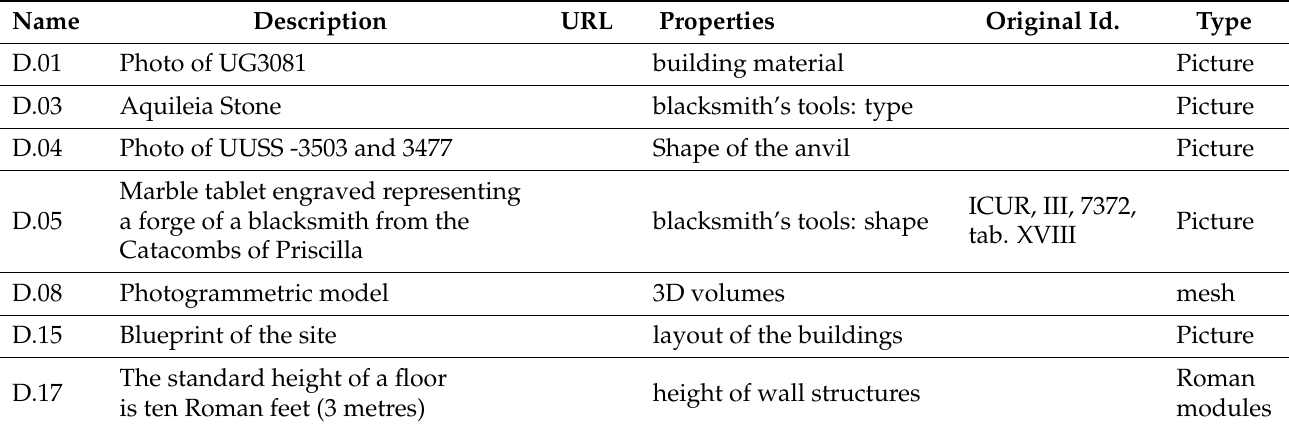
Table 2. Example from the Montebelluna case study (Section 4.6) of an excerpt of the source table for data collection.